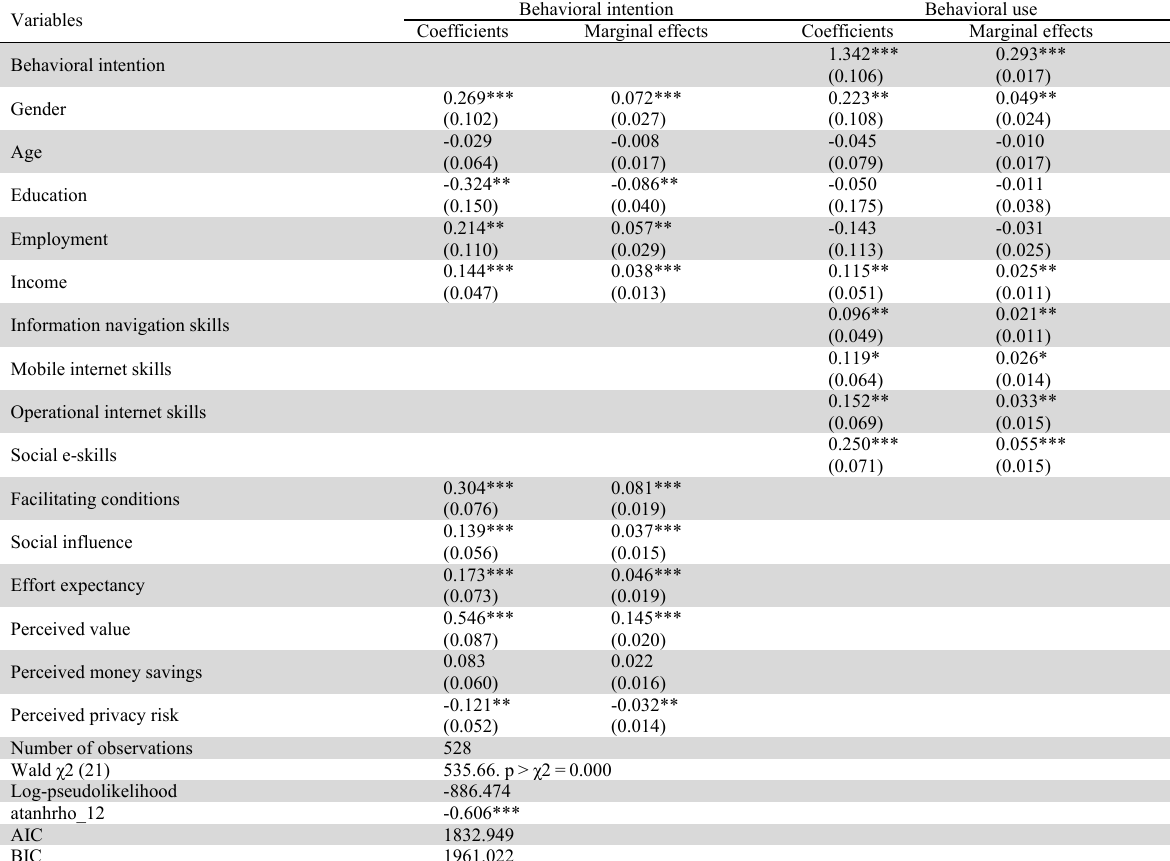
Determinants of the usage of e-services in the hospitality industry